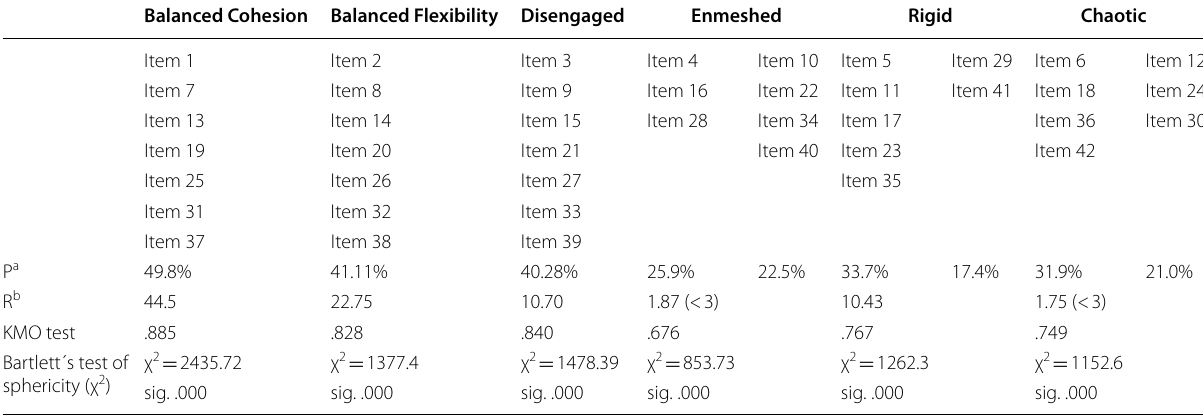
P a Percentage of variance explained by each AFE factor (eigenvalues-greater-than-one rule) = R b ratio between the difference of the first and second eigenvalues and the difference between the second and third eigenvalues =